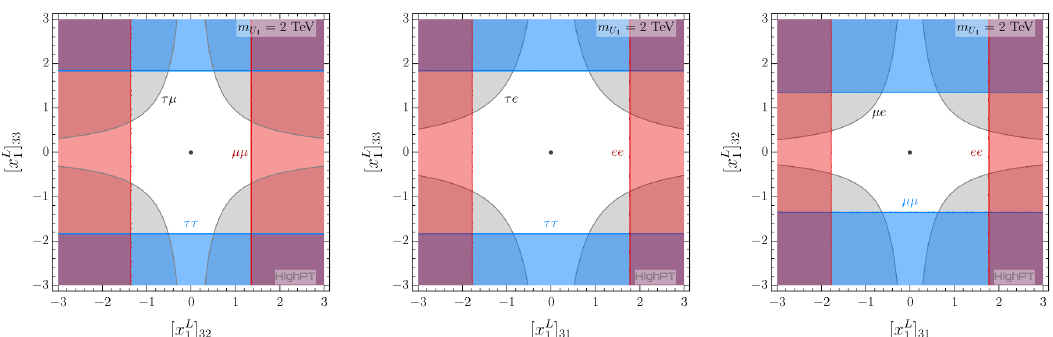
Figure 11. Two-dimensional exclusion regions on the U 1 ∼ ( 3 , 1 , 2 / 3) leptoquark left-handed couplings derived from pp → ‘‘ and pp → ‘ 0 ‘ 0 (red and blue contours), and pp → ‘‘ 0 (gray contours), with ‘ 6 = ‘ 0 . All contours are depicted at 2 σ